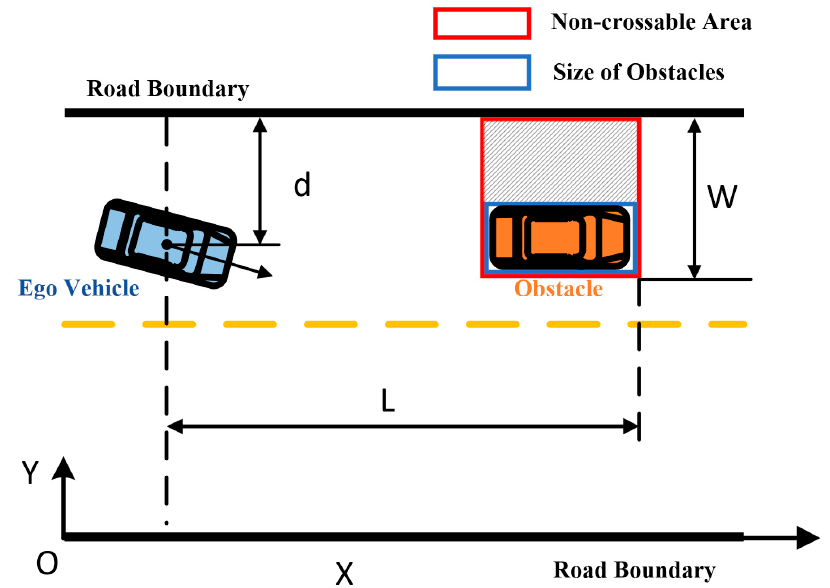
Figure 3. Non-crossable area generation.